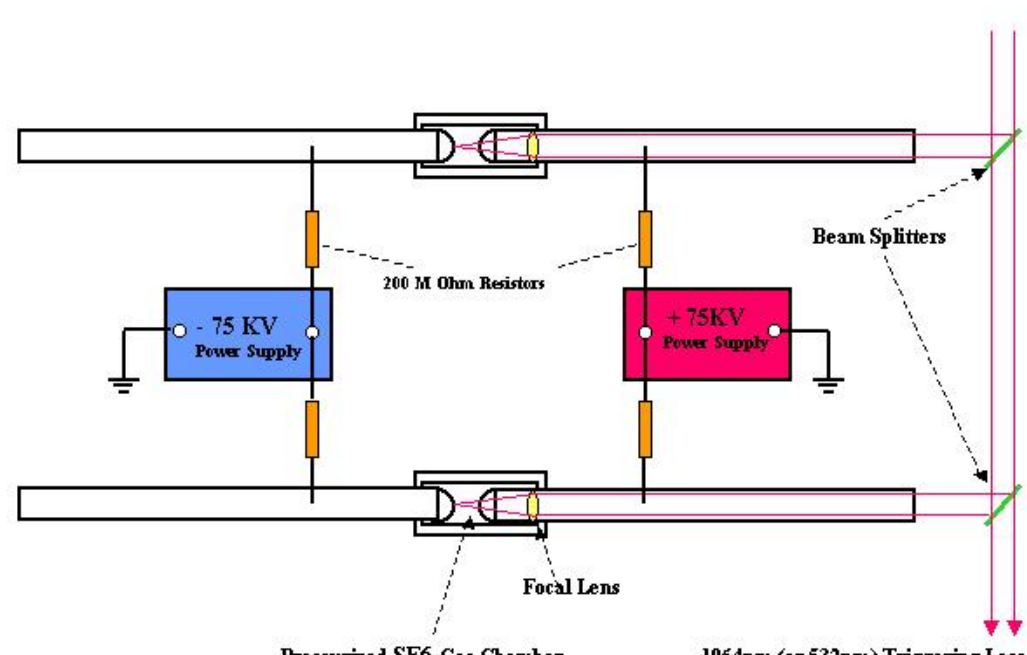
Fig. 7. Schematic of the dual 80-MHz antenna laser triggering experiment.